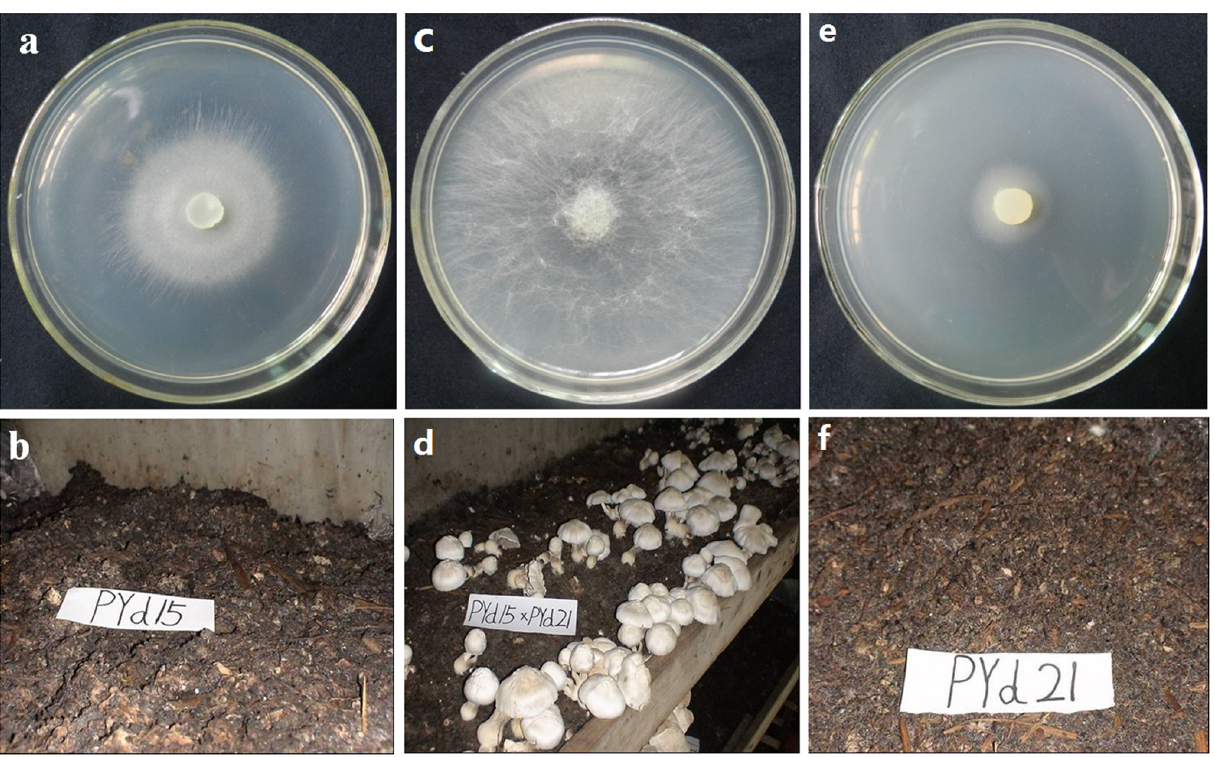
Figure 1. The colonial characteristics of V.volvacea stains PYd15(a, b), H1521(c, d) and PYd21(e, f). (a,c,e). strains were growth on PDA plates and images were captured after 4 d of growth. (b,d,f). strains were growth on a straw-based medium and images were captured after 15 d of cultivation.